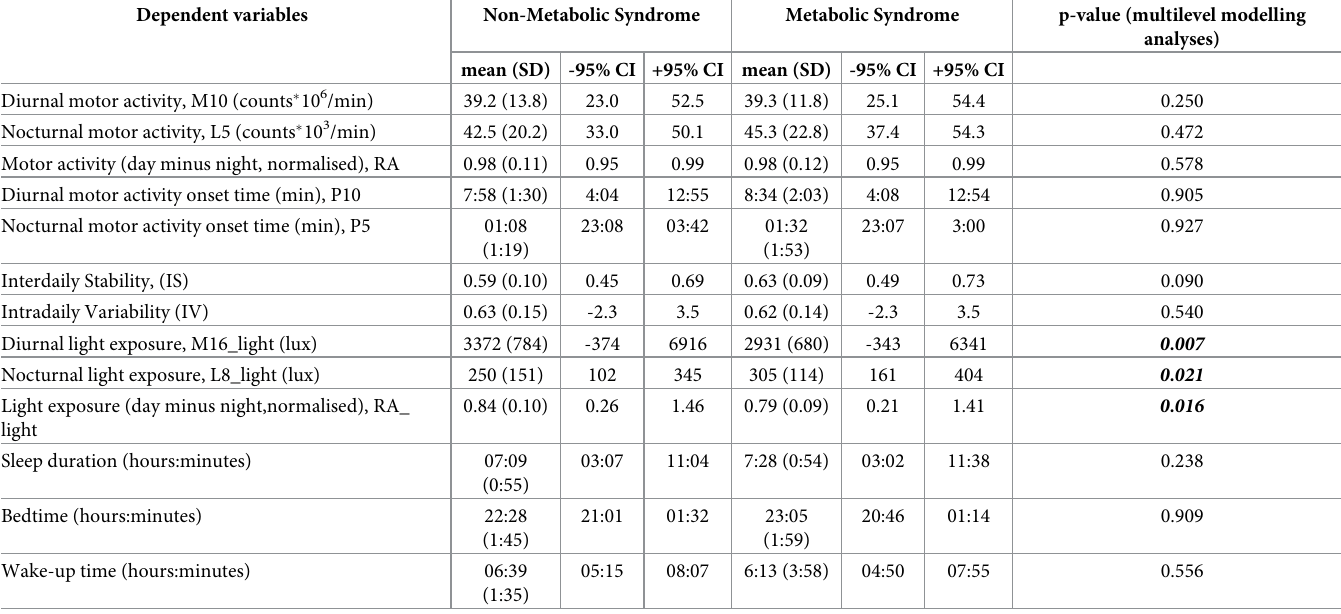
Table 3. Motor activity, light exposure and sleep variables, separated by groups.